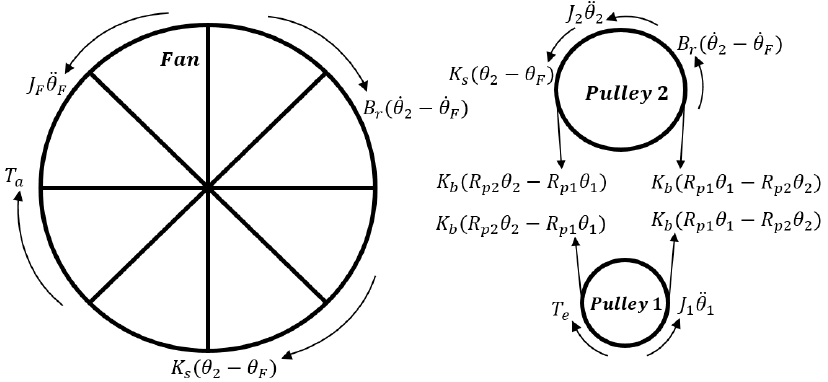
Figure 4. Free-body diagram of the fan/motor